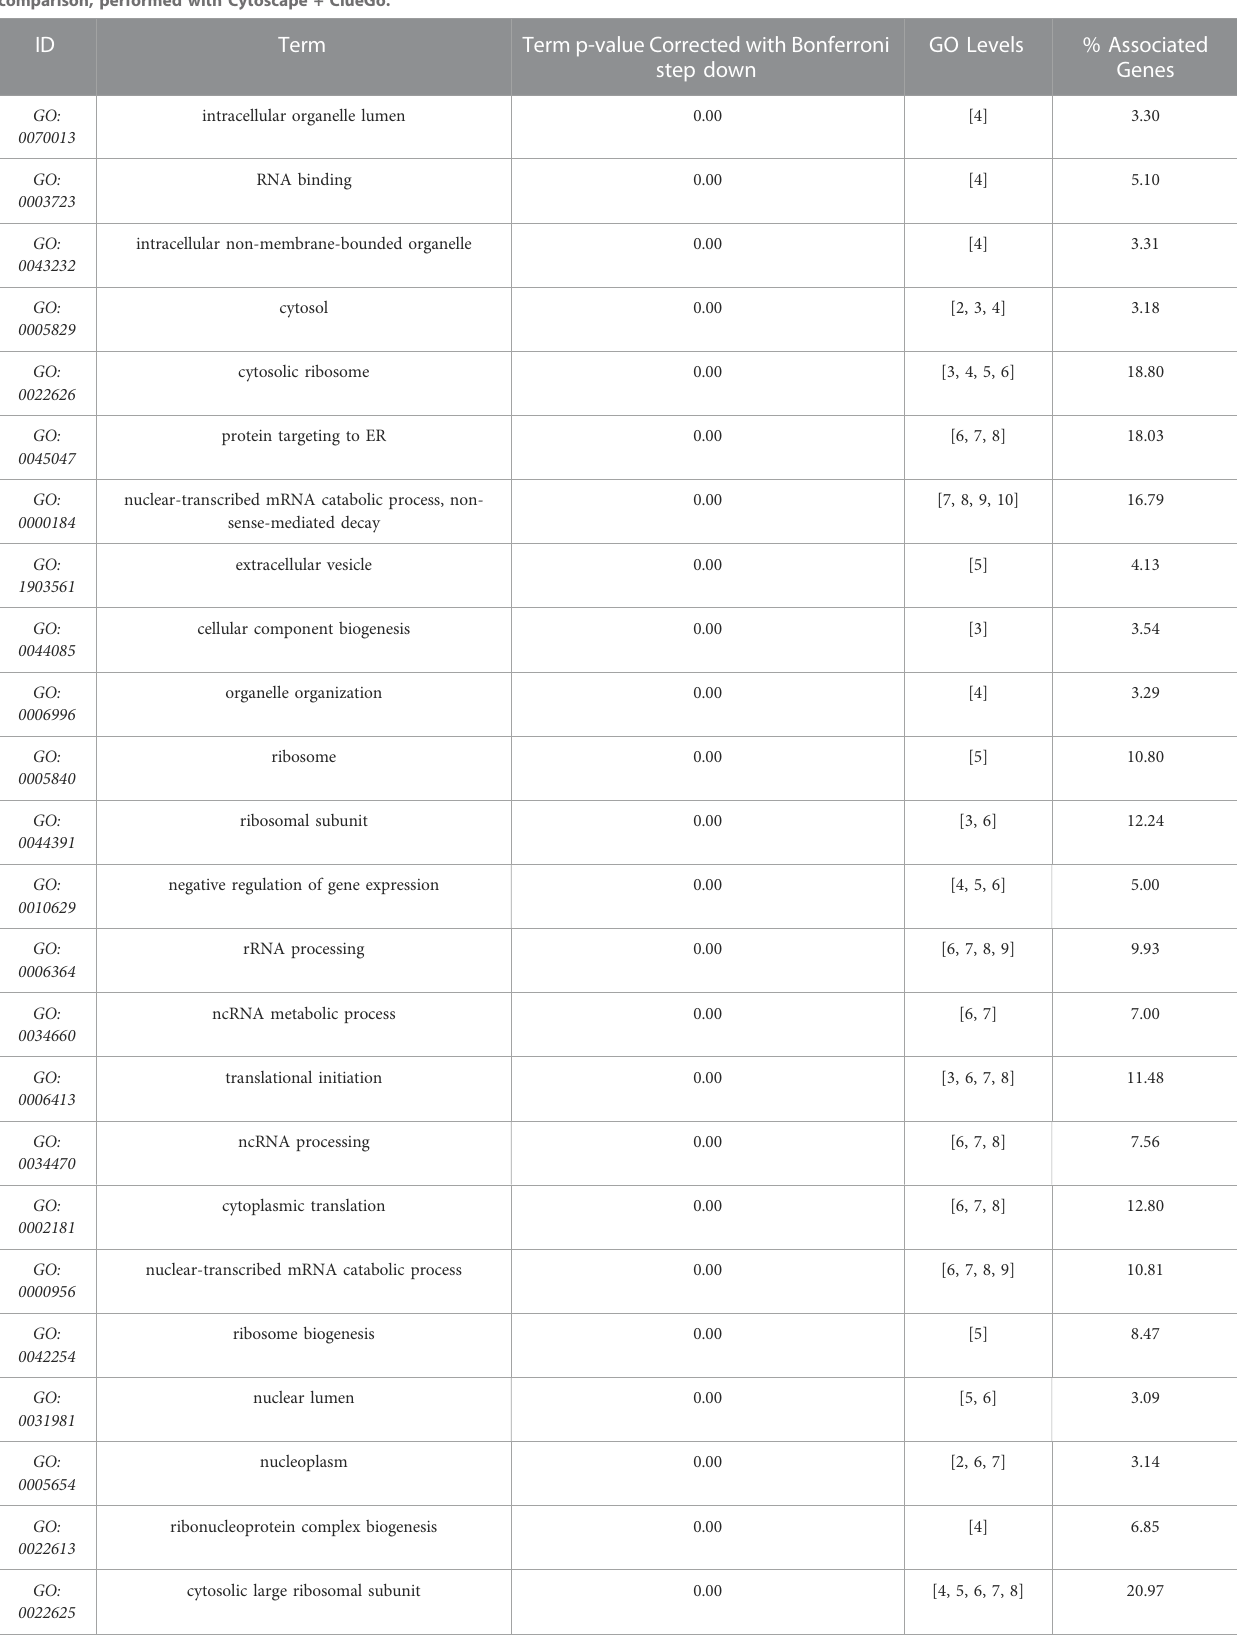
TABLE 3 GO terms (molecular function, cell compartment, and biological process) most signi fi cantly represented (Bonferroni correction), from AS3 to LT comparison, performed with Cytoscape + ClueGo. ID Term Term p-value Corrected with Bonferroni